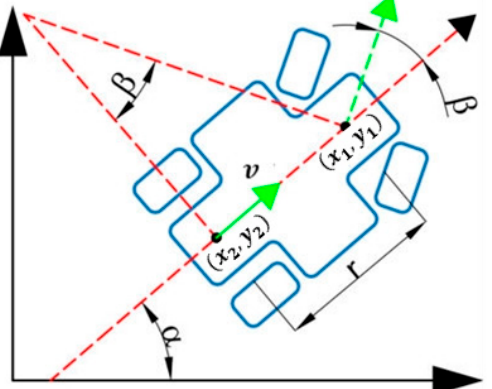
Figure 7. Kinematics Model of Robot α refers to the horizontal angle between the vehicle center line and the coordinate system X axis, β to the turning angle of the robot, r to the distance from the center of the front axle to that of the rear axle of the robot, v to the forward speed of the robot and ( x 1 , y 1 ) , ( x 2 , y 2 ) to the center coordinates of the front and rear axles of the robot.